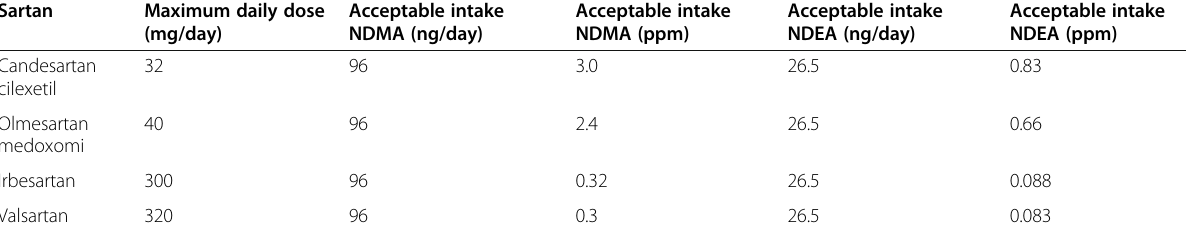
Table 1 Interim limits for NDMA and NDEA in sartan substances set by FDA